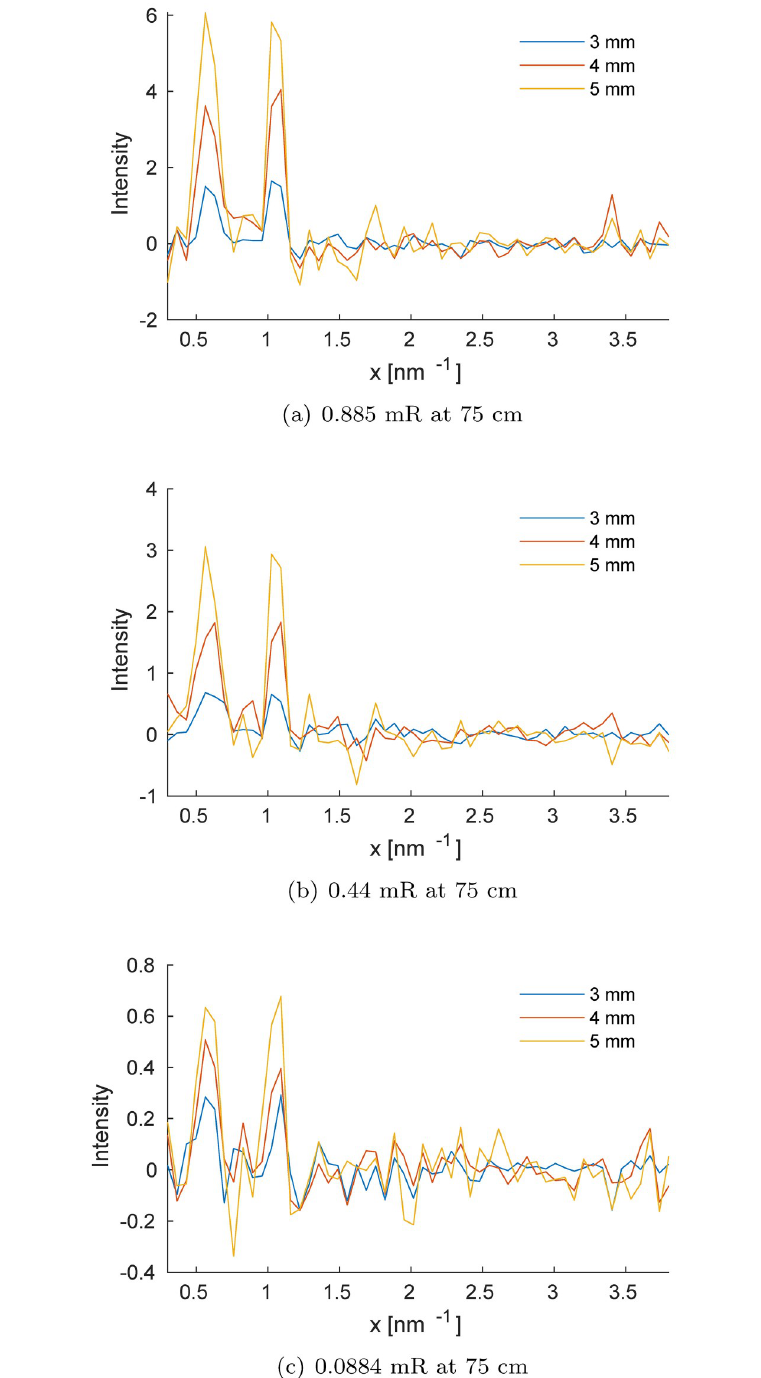
Fig 4. Signal amplitude of the β A that corresponds to the difference between the two scatter spectra measured with and without simulated amyloid inserts for three different incident exposure levels and for various diameters of amyloid inside the effective inspected